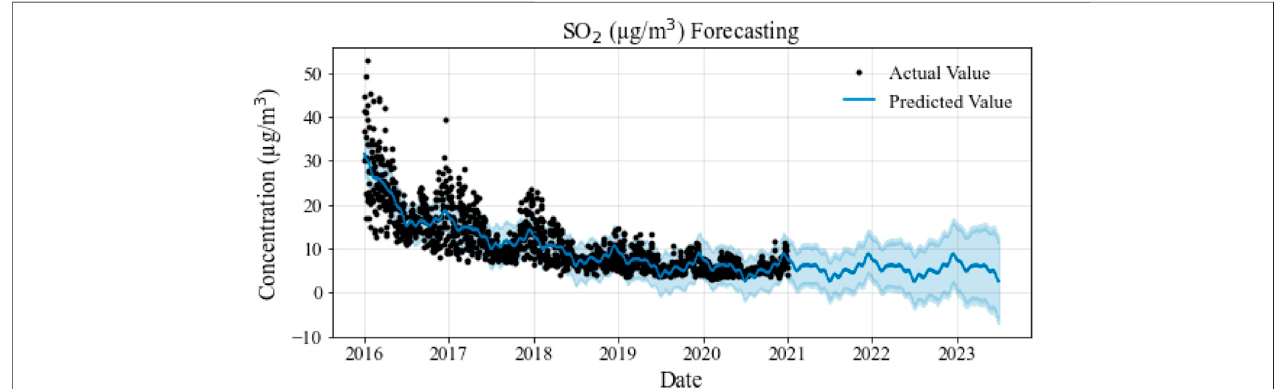
FIGURE 5 | SO 2 (µg/m 3 ) forecasting in jiangsu